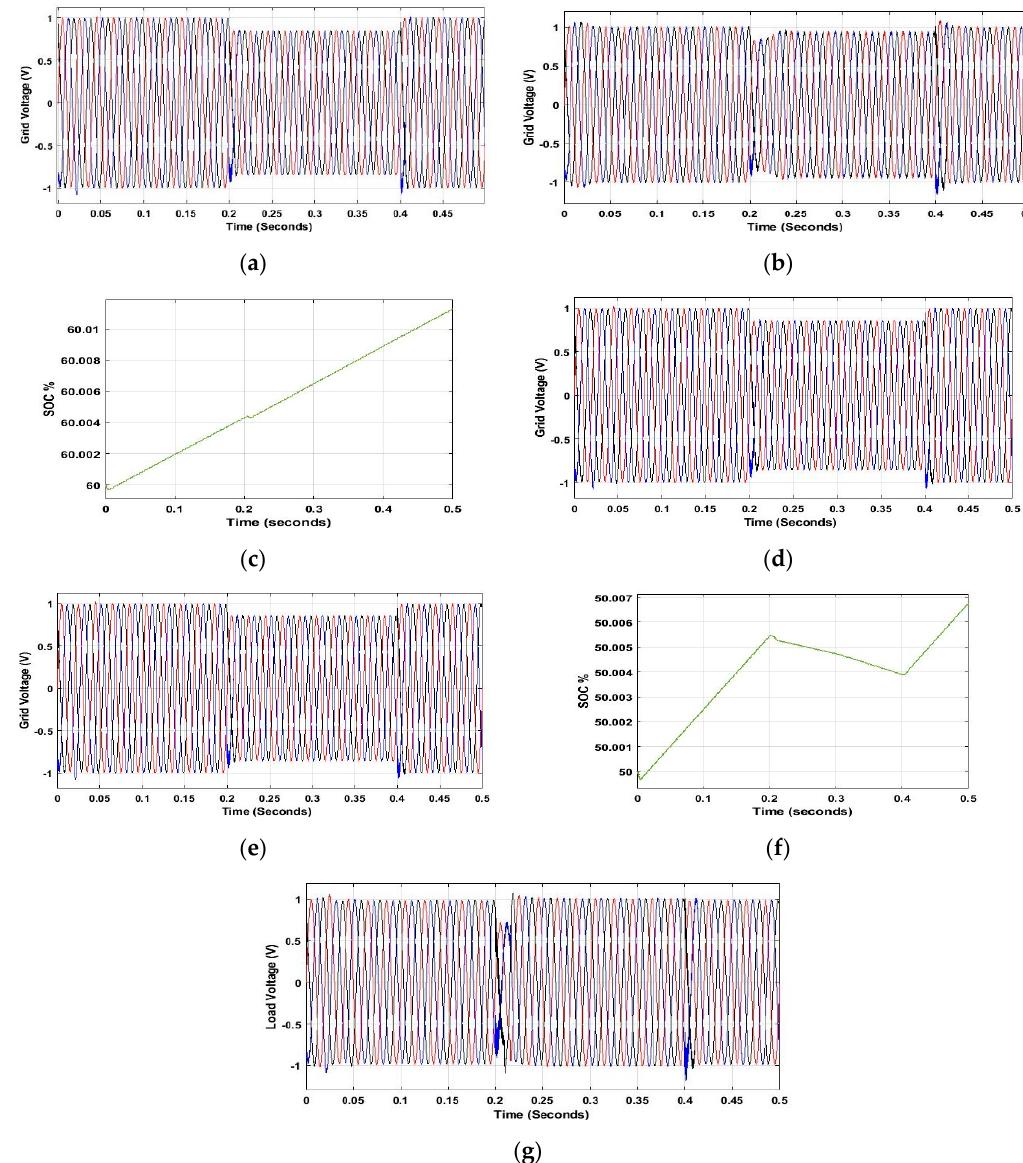
Figure 11. Voltage sag compensation simulation results. ( a ) Grid voltage with sag depth of 0.85 pu. ( b ) Compensated load voltage when no charging command. ( c ) State of Charge (SOC) of electric vehicle (EV) battery when small voltage sag occurs. ( d ) Grid voltage of sag of depth of 0.86 pu. ( e ) Compensated load voltage during small voltage sag event. ( f ) SOC of EV battery during deep voltage sag compensation. ( g ) Compensated load voltage during deep voltage sag event.